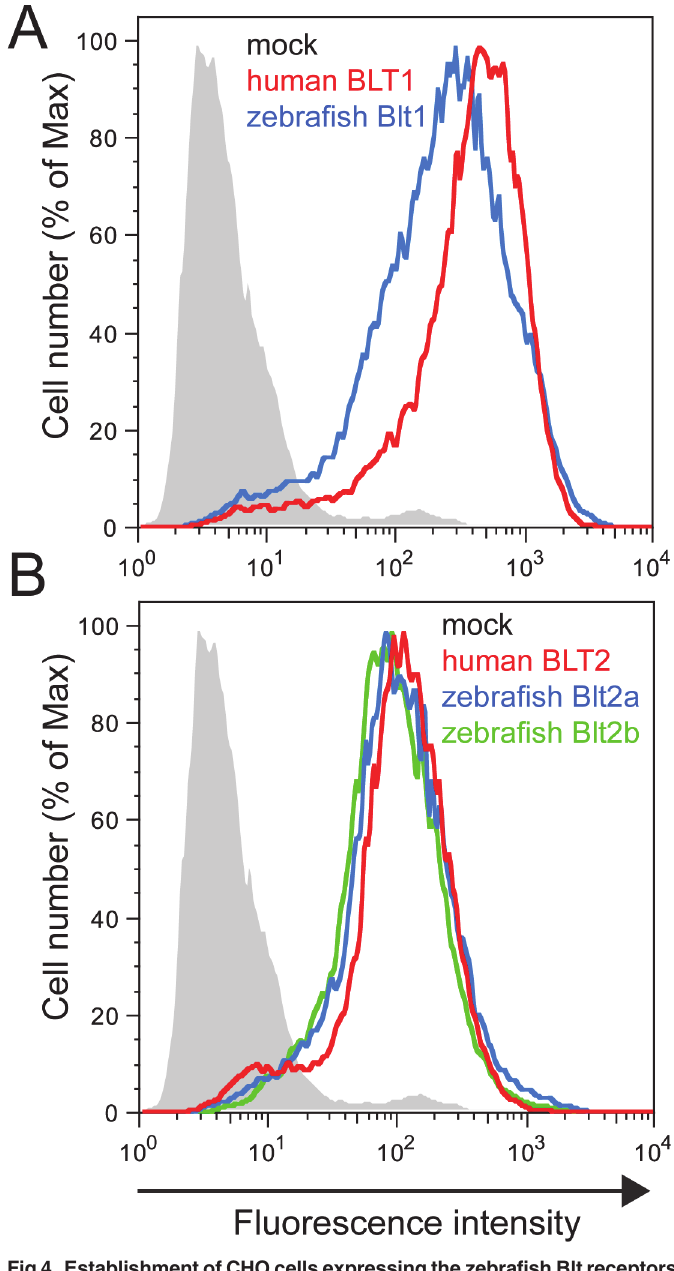
Fig 4. Establishment of CHO cells expressing the zebrafish Blt receptors. CHO cells stably expressing hBLT1, zebrafish Blt1, hBLT2, zebrafish Blt2a, or Blt2b were sorted after staining the cell surface Blts using an anti-HA antibody, and the surface expression was analyzed by flow